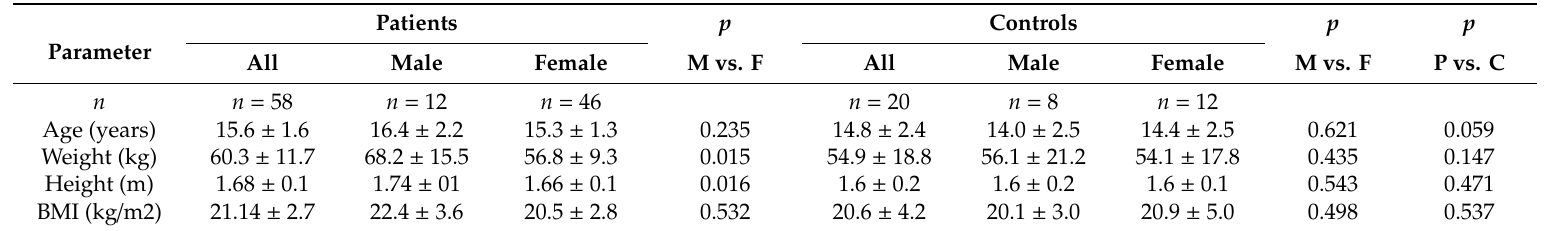
Table 1. Anthropometric parameters of evaluated depressive patients and